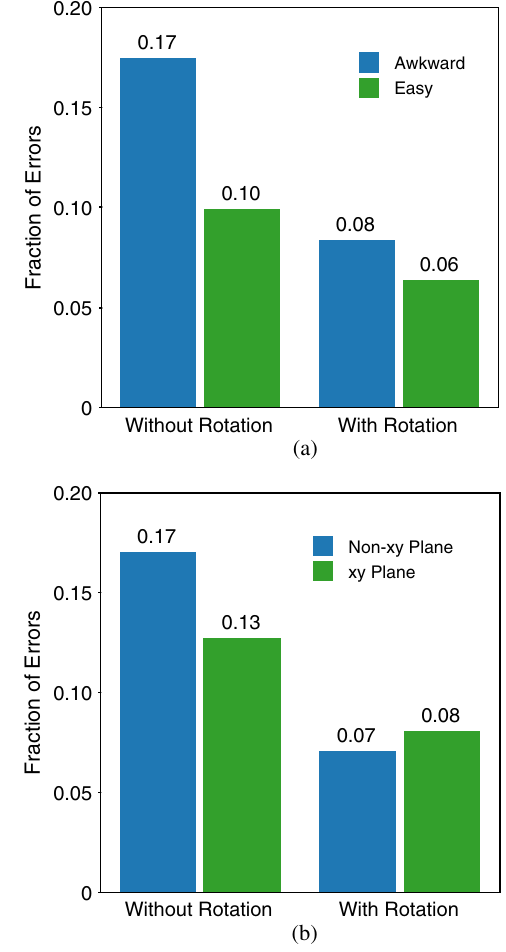
FIG. 13. Interaction of rotation and orientation: (a) fraction of RHR errors on physically easy and awkward problems with and without rotation; (b) fraction of RHR errors on problems in the xy and non- xy planes with and without